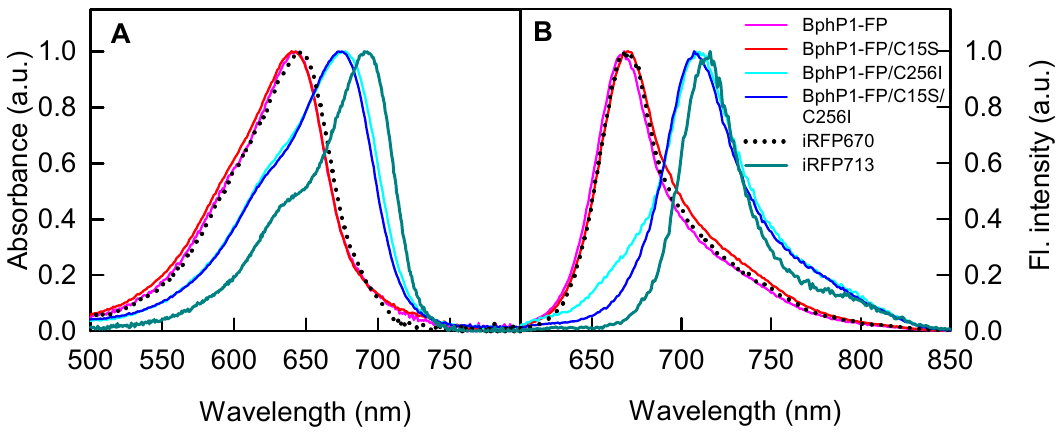
Figure 3. Spectral properties of BphPl-FP and its variants with different location of Cys residues. Absorbance ( A ) and fluorescence ( B ) spectra of BphPl-FP and its mutants are shown. Absorbance and fluorescence intensity (Fl. intensity) are presented in arbitrary units (a.u.). Fluorescence emission was excited at 600 nm.